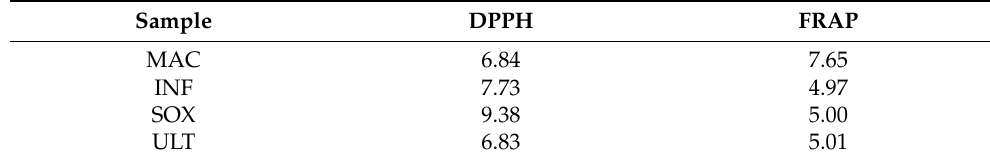
Table 1. Effective concentration (mg/mL) to inhibit 50% of DPPH and FRAP radicals for rosemary extracts obtained by maceration (MAC), infusion (INF), Soxhlet (SOX), and ultrasound (ULT).